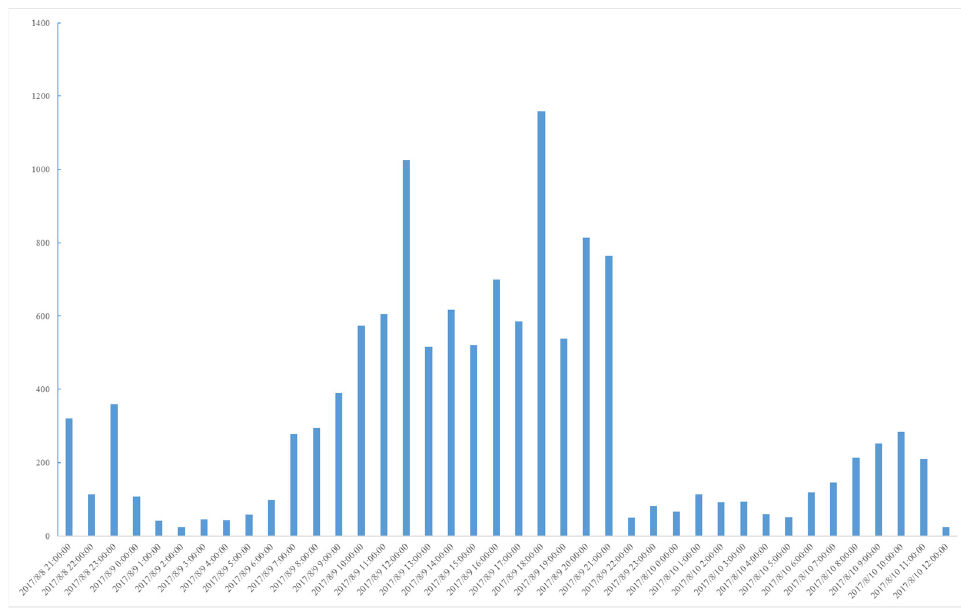
Figure 5. Message volume per hour of 05SC earthquake.